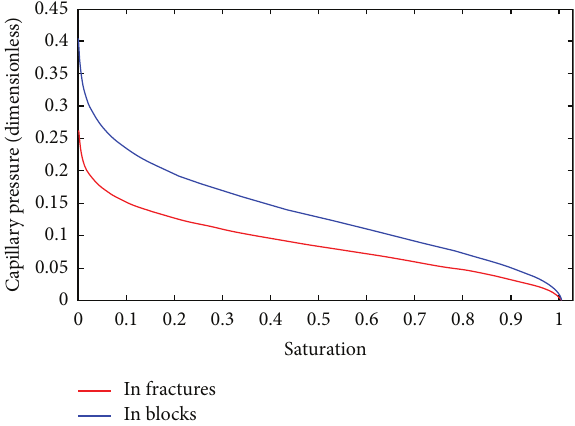
Figure 2: Capillary pressure as function of saturation for blocks and fractures.